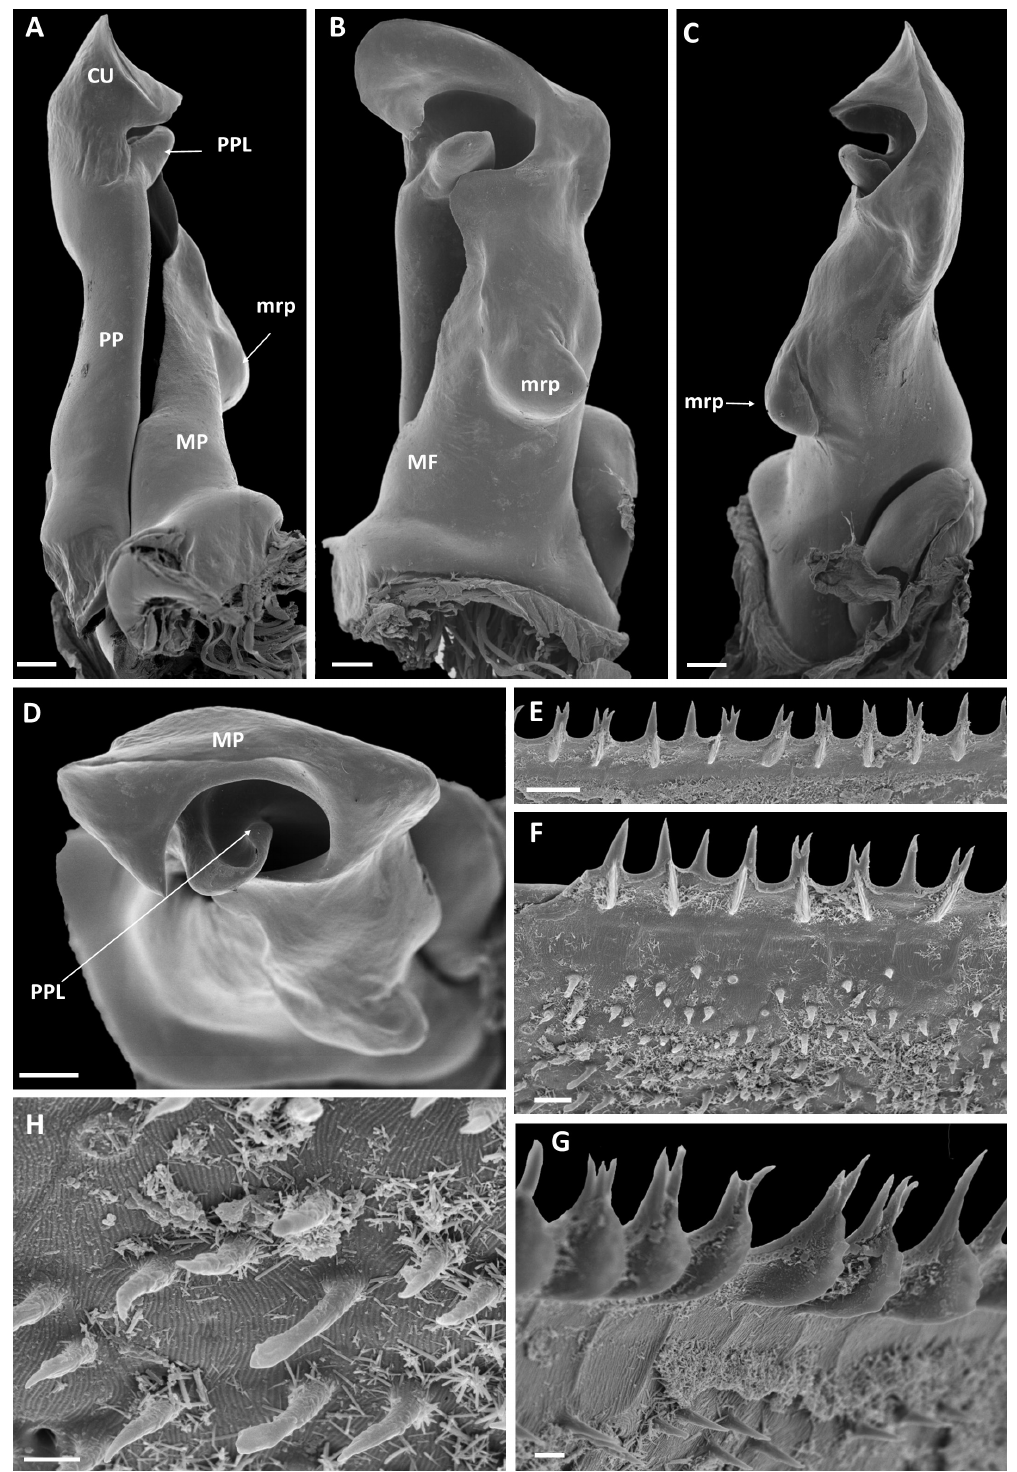
Fig. 44. Multipronopea agneteae gen. et sp. nov., holotype, ♂ (NHMD 621749). A–D . Left gonopod coxa. A. Anterior view. B. Mesal view. C. Posterior view. D. Apical view. E–G . Midbody dorsal limbus. H . cuticle near limbus. Abbreviations: CU = cucullus; MF = metaplical flange; MP = metaplica; mrp = metaplical rounded process PP = proplica; PPL = proplical lobe. Scale bars: A–D = 0.1 mm; E = 0.01 mm; F = 0.005 mm; G–H = 0.002